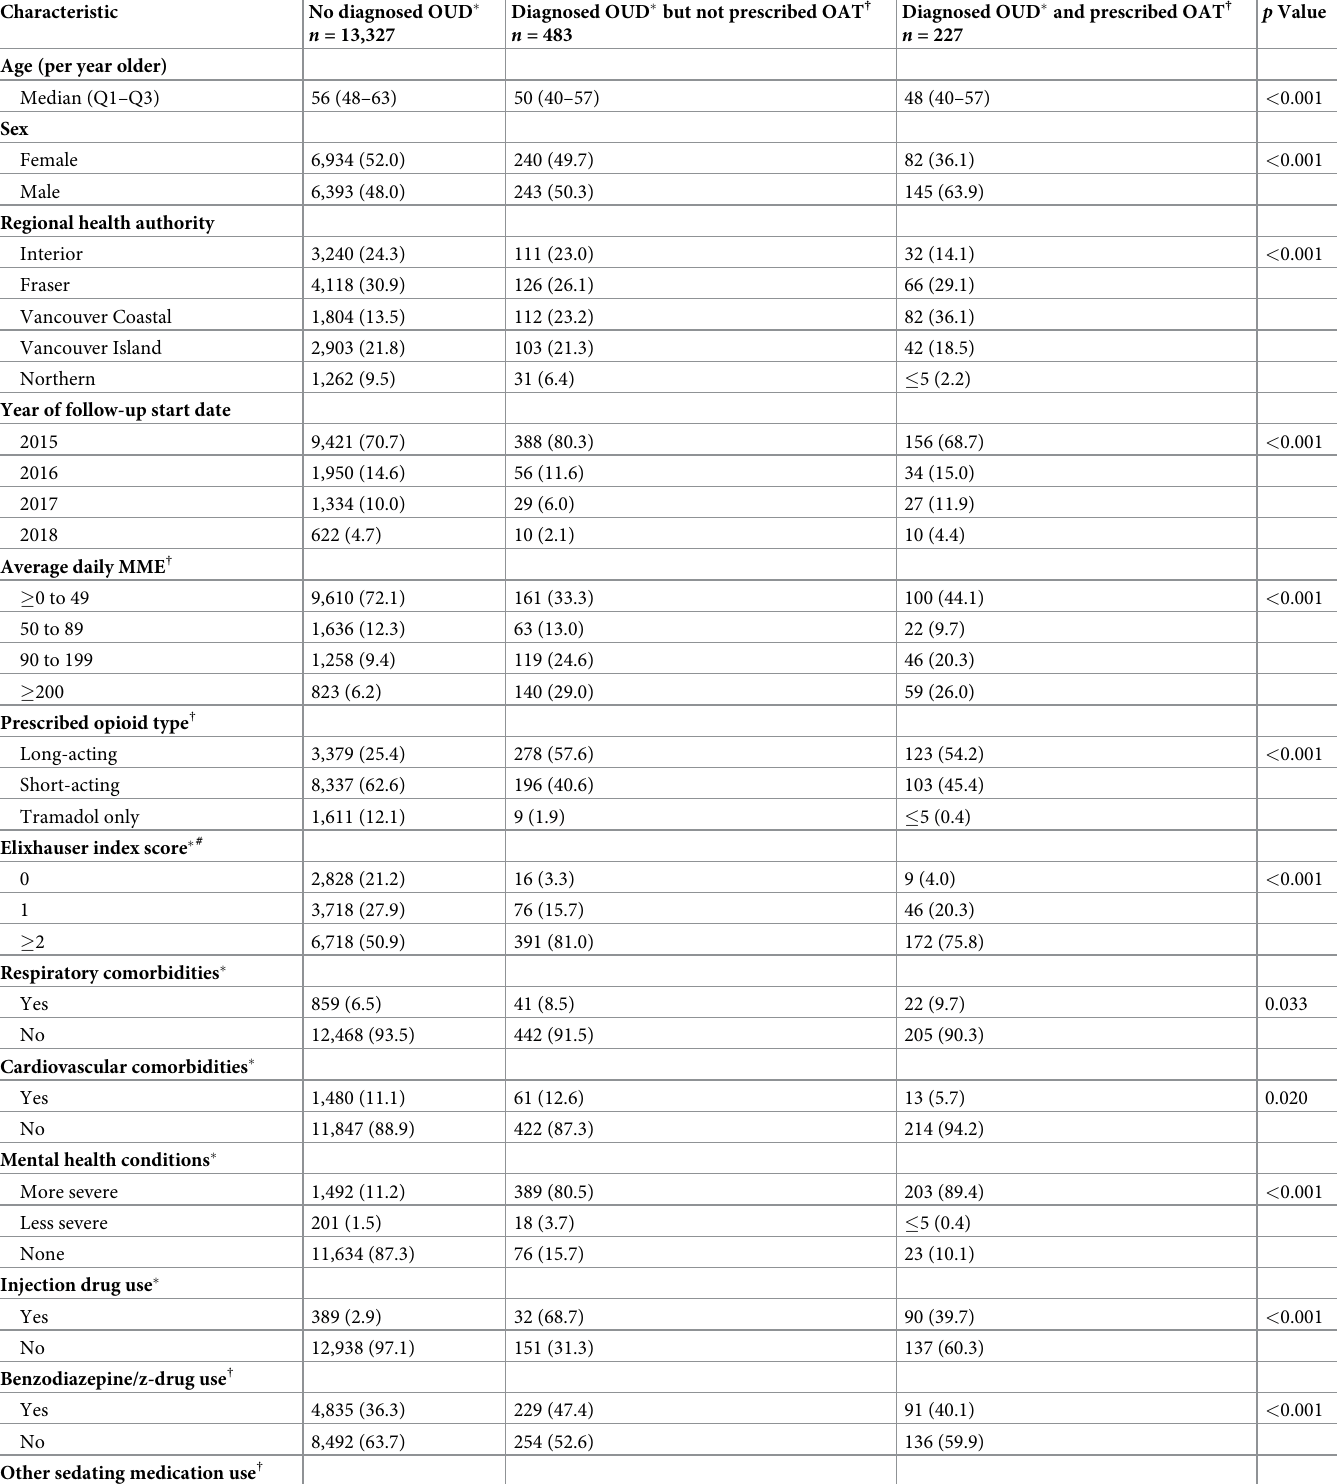
Table 1. Baseline characteristics among people on long-term opioid therapy for pain in British Columbia, Canada, stratified by OUD � and OAT † status ( n =